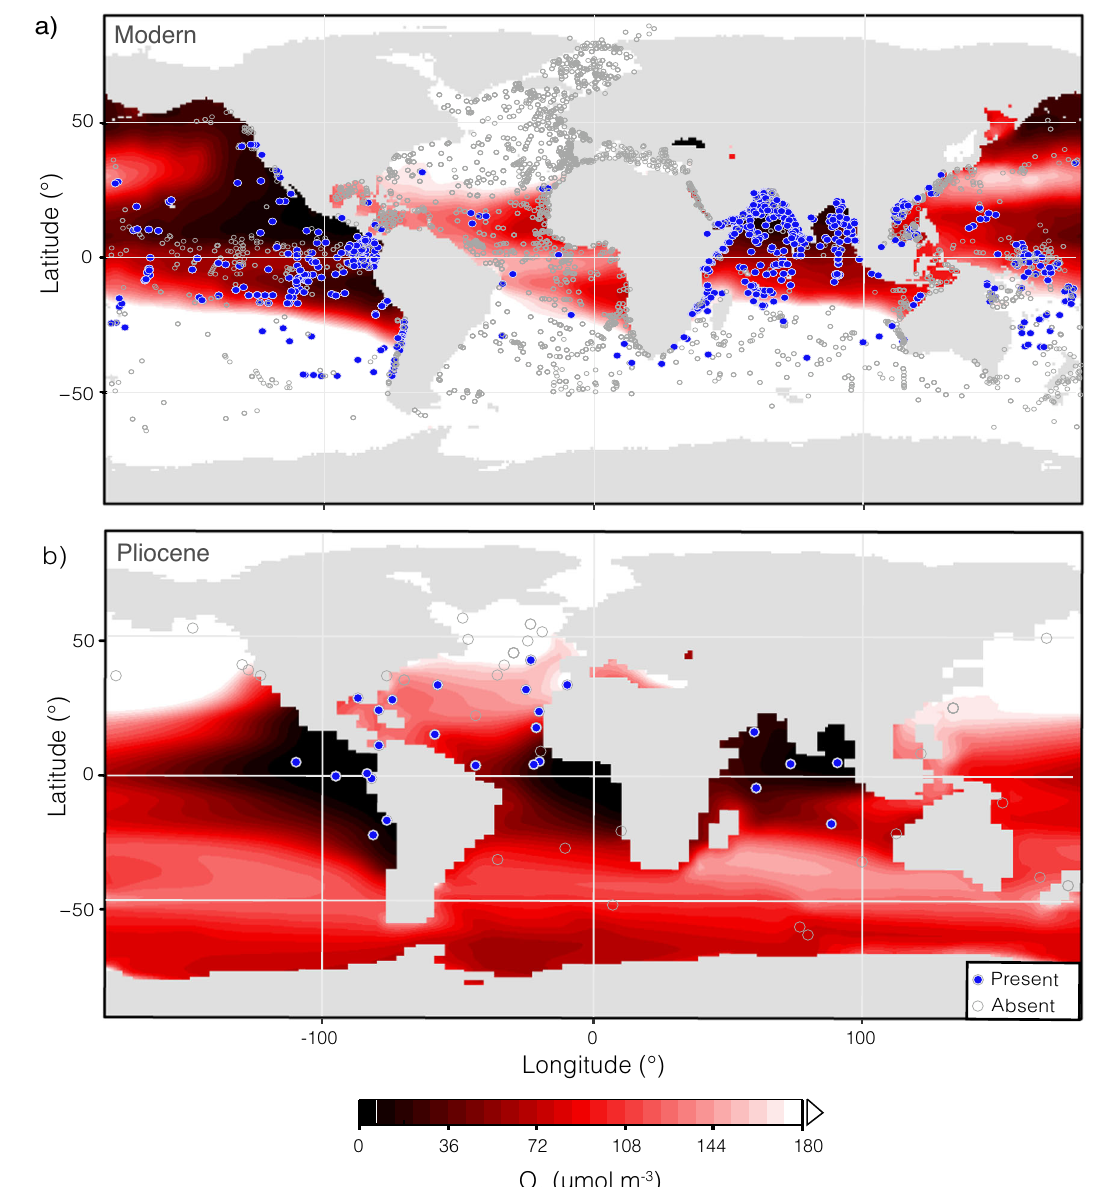
Fig. 2 | Distribution of low-oxygenaf fi liatedplanktic foraminifer G.hexagonus and oxygen at ~600m in the modern and Pliocene oceans. Oxygen concentra- tions at ~600m depth a ) aggregated from WOA18 data (1955-2010) 90 , and b ) from the Pliocene-like CESM simulation. Sites where G. hexagonus was found to be